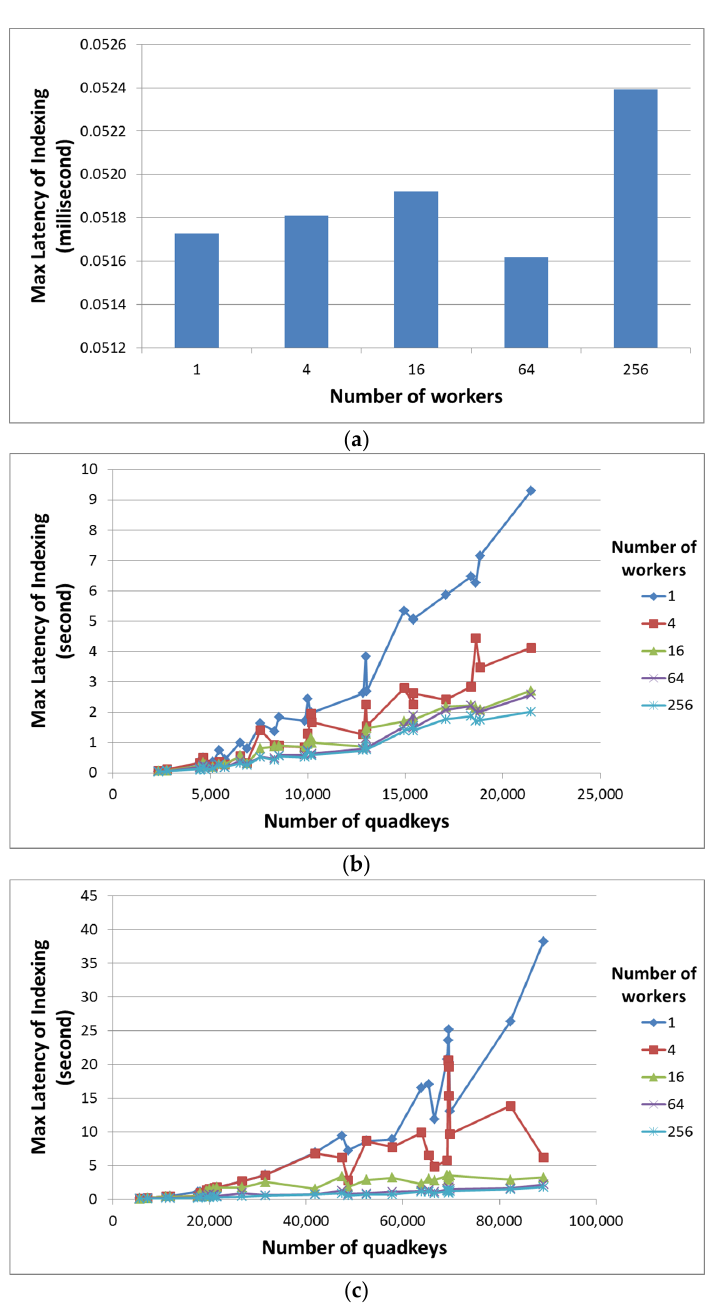
Figure 5. The indexing latency for ( a ) point; ( b ) line; and ( c ) polygon geometry.